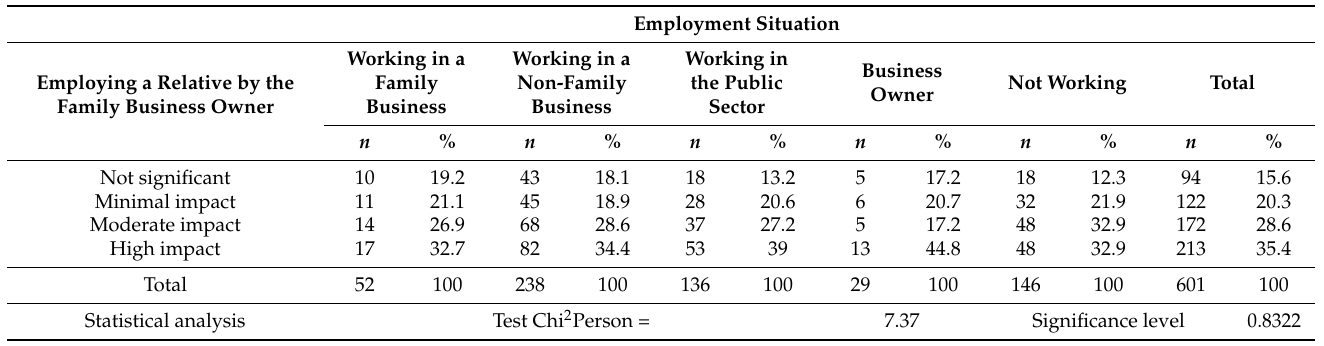
Table 7. Statistical analysis of the assessment of the impact of the Covid pandemic on employing a family member by the owner of the family business depending on the place of work.